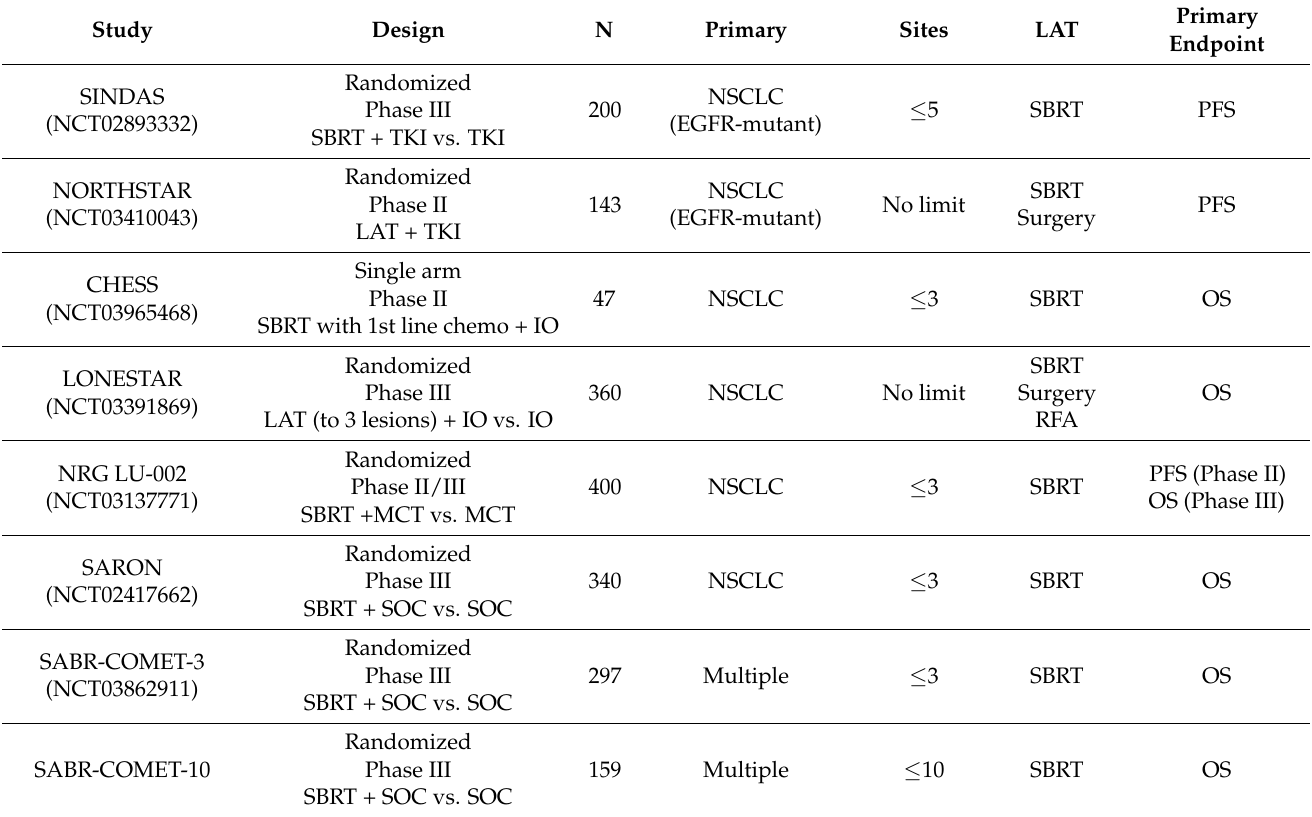
Table 2. Randomized trials of radiation as local ablative therapy for oligometastatic NSCLC in